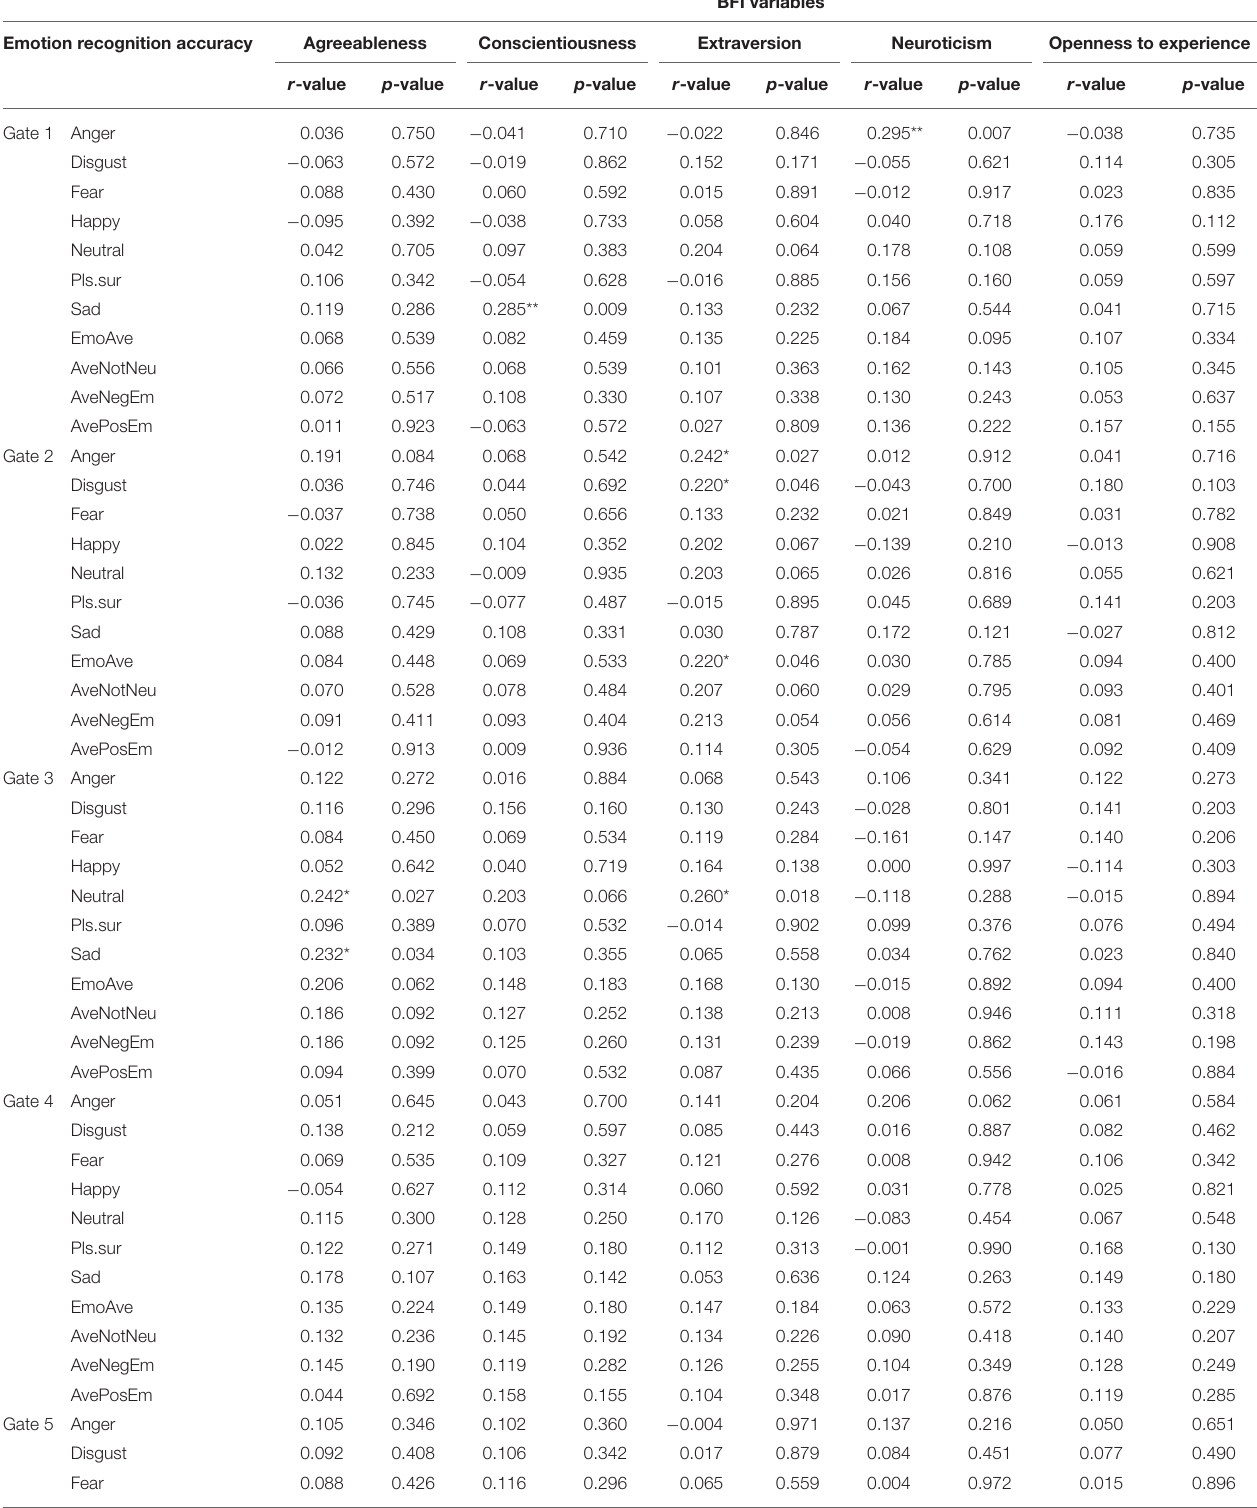
TABLE 5 | Pearson’s correlations ( r -value) and their significance level (* p < 0.05, ** p < 0.01) between Hu scores at individual gates and the Big Five Inventory